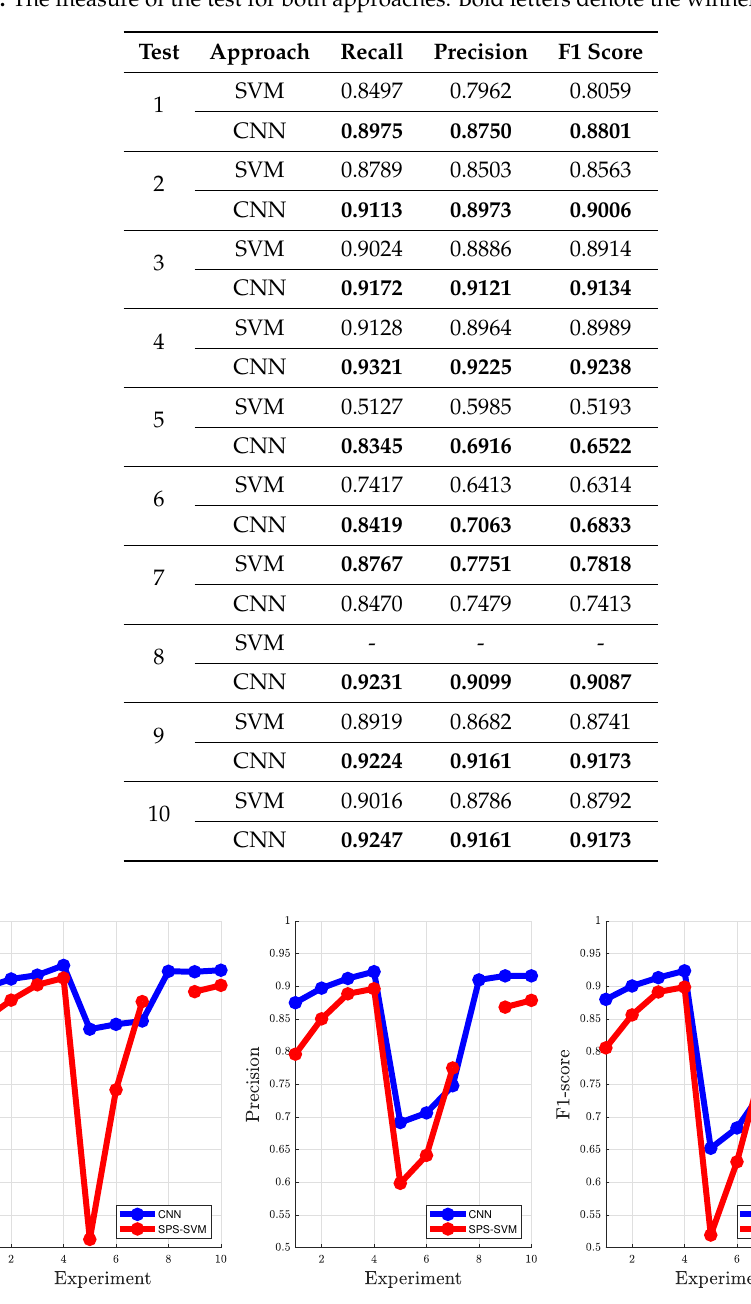
Figure 10. The measure of the test for both